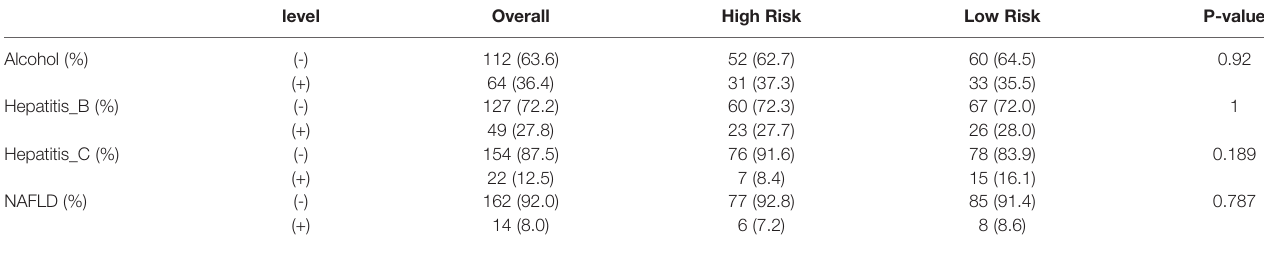
TABLE 4 | Proportion of each causative agents in test cohorts.